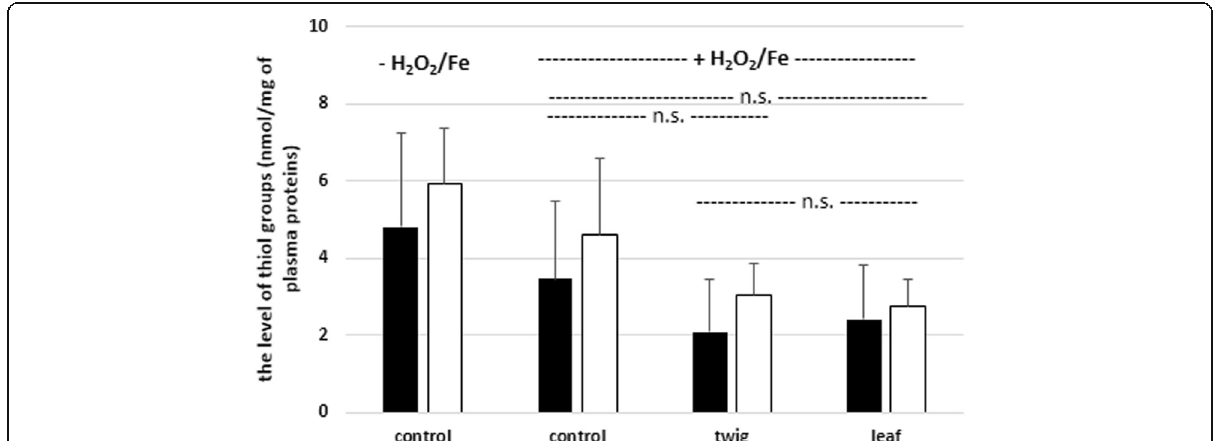
Fig. 5 Effects of SBT twig and leaf extracts (50 μ g/mL; 15 min and 60 min) on oxidation of plasma protein thiols induced by H 2 O 2 /Fe. Data represent means ± SD of 6 – 9; p > 0.05 (n.s.). Control negative refers to plasma not treated with H 2 O 2 /Fe, whereas control positive to plasma treated with H 2 O 2 /Fe. black diagram – 15 min, white diagram – 60 min